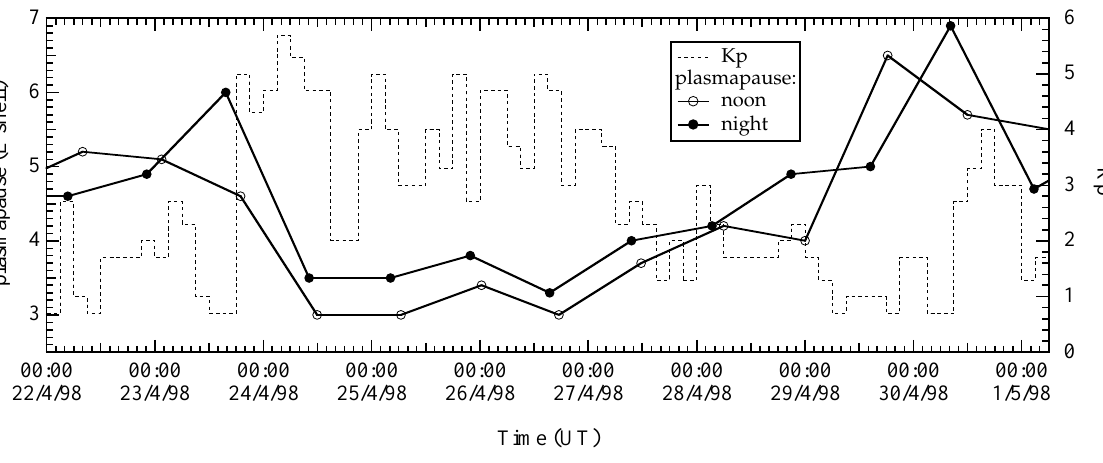
Fig. 7. Locations of the plasmapause near noon and midnight on 22–30 April 1998; the L-shell scale from 3 to 7 is given on the left axis. The panel also presents the variation of the 3-h global K p index, shown by a dashed line, with a scale on the right axis.